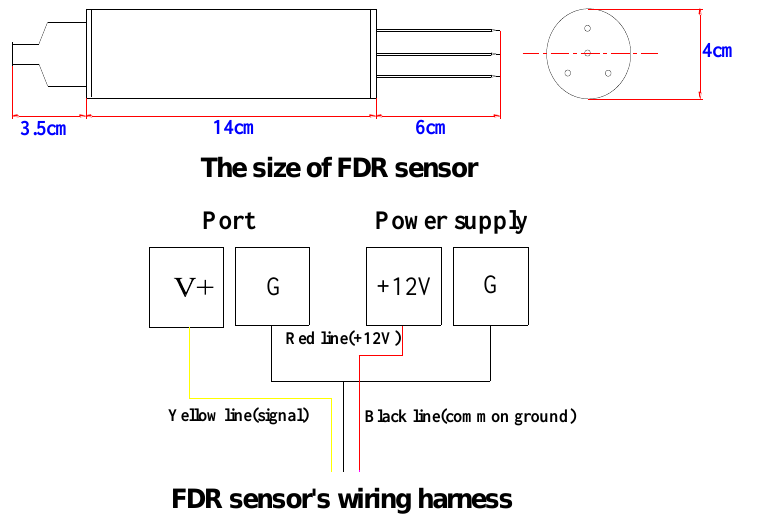
Figure 1. Dimensions of the FDR sensor.